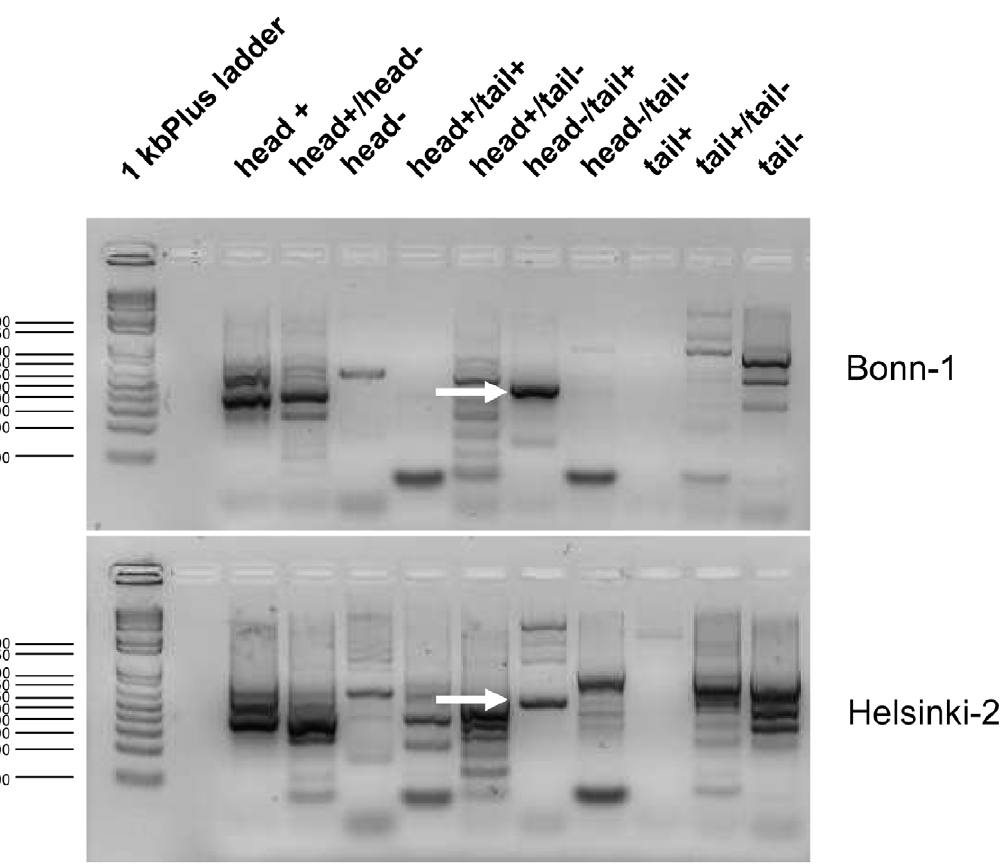
Figure 4. Agarose gel elctrophoreses of PCRs with all possible combinations of head- and tail-primer pairs. Two representative gel pictures are shown. All bands were gel extracted and subject to sequencing and cloning and sequencing from both directions. Arrows indicate the band that contained the HBoV head-to-tail sequences.